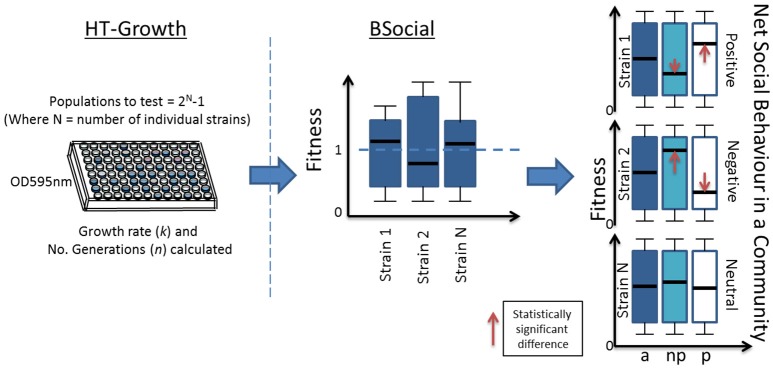
Deciphering social behavior using the combination of HT-Growth and BSocial methods. The number of populations depend on the number of individual strains, and are grown on microtiter plates with continuous OD readings at regular intervals, enabling n (number of generations) and k (growth rate) calculations. All the data points (a) are normalized with each individuals n or k. Data points are then separated according to absence (np) or presence (p) of the individual strain in the population. Statistical differences between the means of np and p will return a net positive or negative social behavior, whereas a non-difference will determine the strain to have a neutral social behavior.